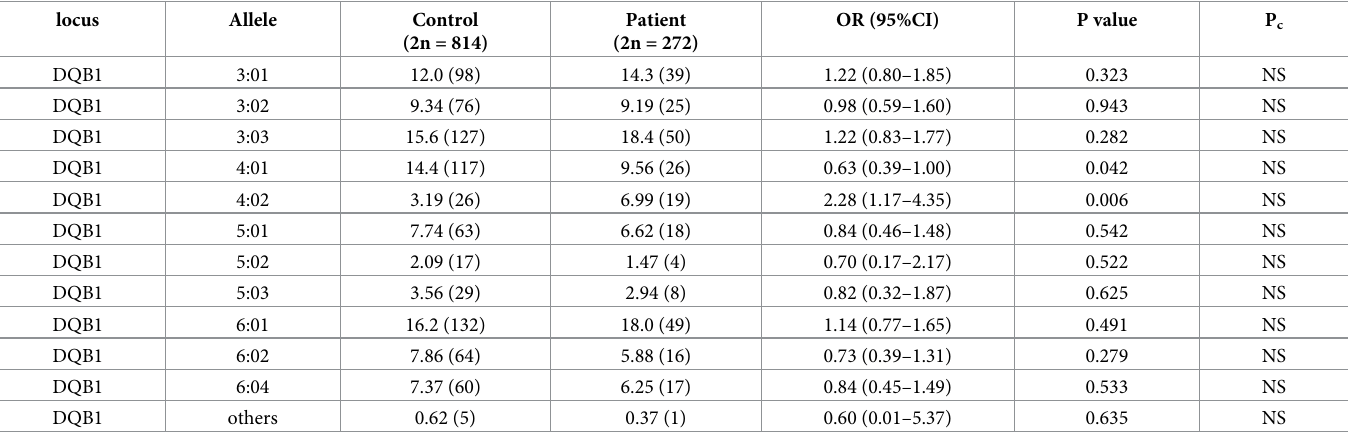
The number of allele carriers is shown in parentheses. The association was examined by the chi-square test. Corrected P -values ( P c ) statistically significant after Bonferroni correction are indicated in bold. OR, odds ratio; CI, confidence interval; P c , corrected P- value; NS, not